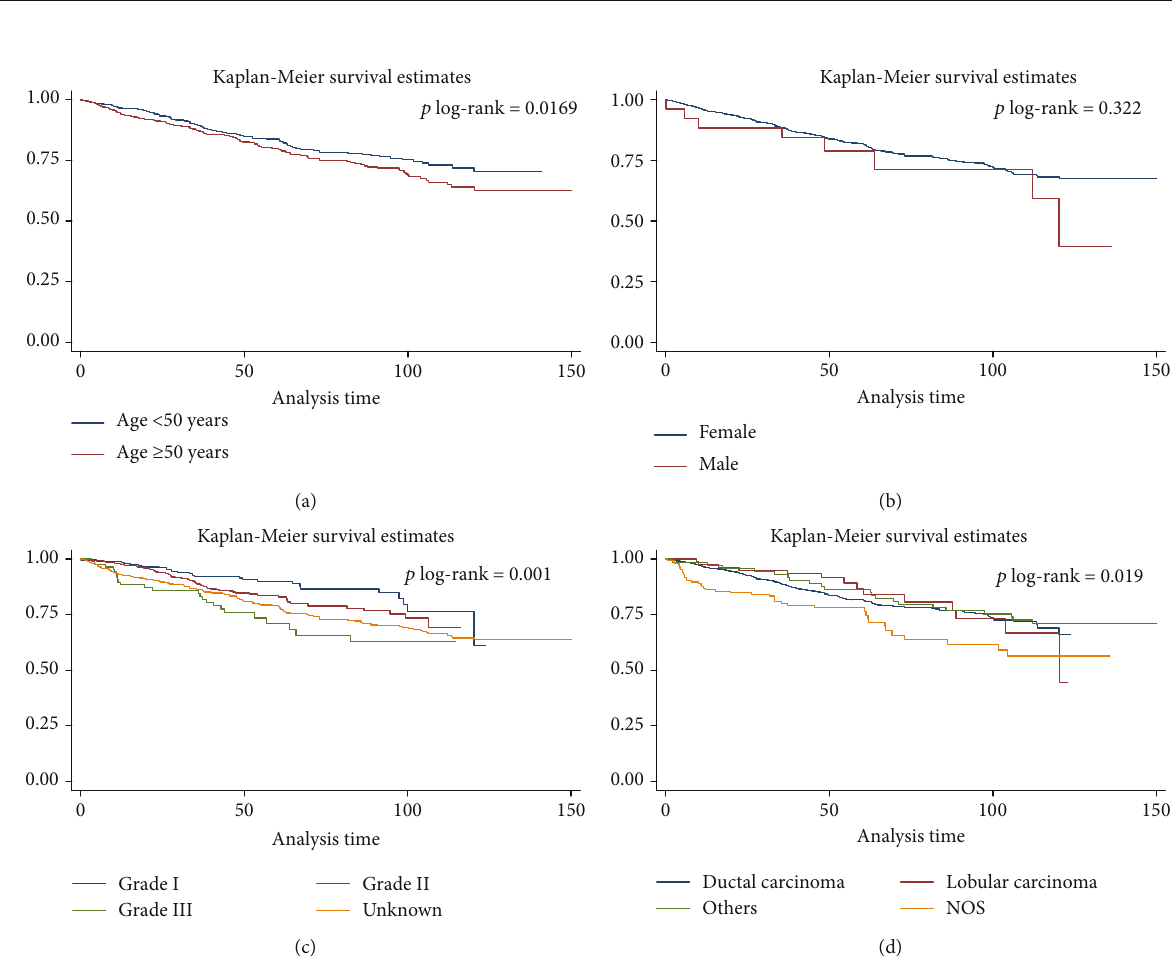
Figure 1: Kaplan-Meier survival curve, results for the test of equality of breast cancer-speci fi c survival functions for the di ff erent variables in Northwest of Iran, between 2007 and 2016 in both sexes (a) age groups, (b) sex groups, (c) grades, and (d) morphologic